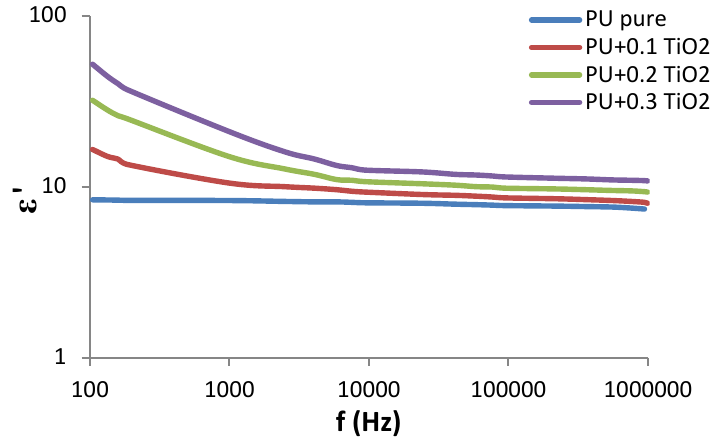
Fig. 2: Dielectric constant vs. frequency for PU-TiO